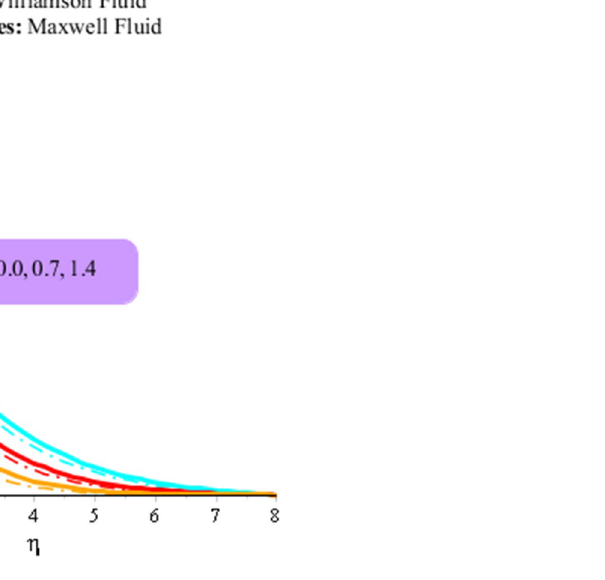
Figure 9. Influence of n r versus temperature